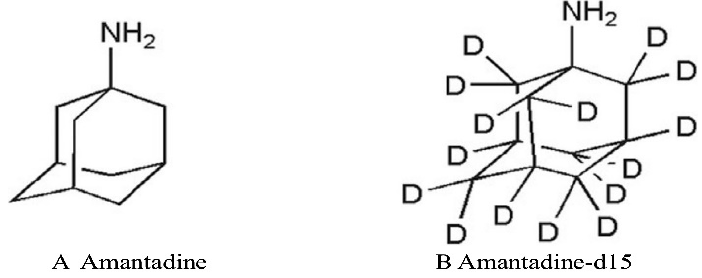
Figure 1. Chemical structure of Amantadine ( A ) and Amantadine ‐ d 15 ( B ).